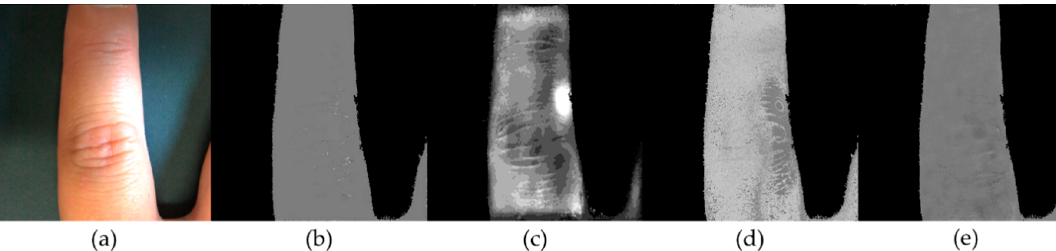
Figure 1. Brief results of 3D skin surface reconstruction from the state-of-the-art depth estimation methods: ( a ) shows center view images taken with directional illumination; ( b ) represents the result from [23]; ( c ) presents the result from [18]; ( d ) shows the estimated depth image obtained from [20]; ( e ) is result from [26].